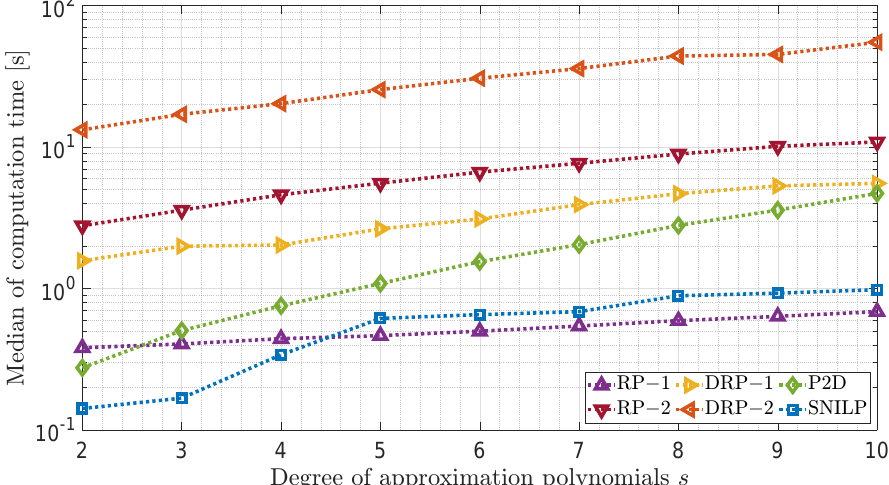
Figure 6. Comparison of vignetting estimation times for individual